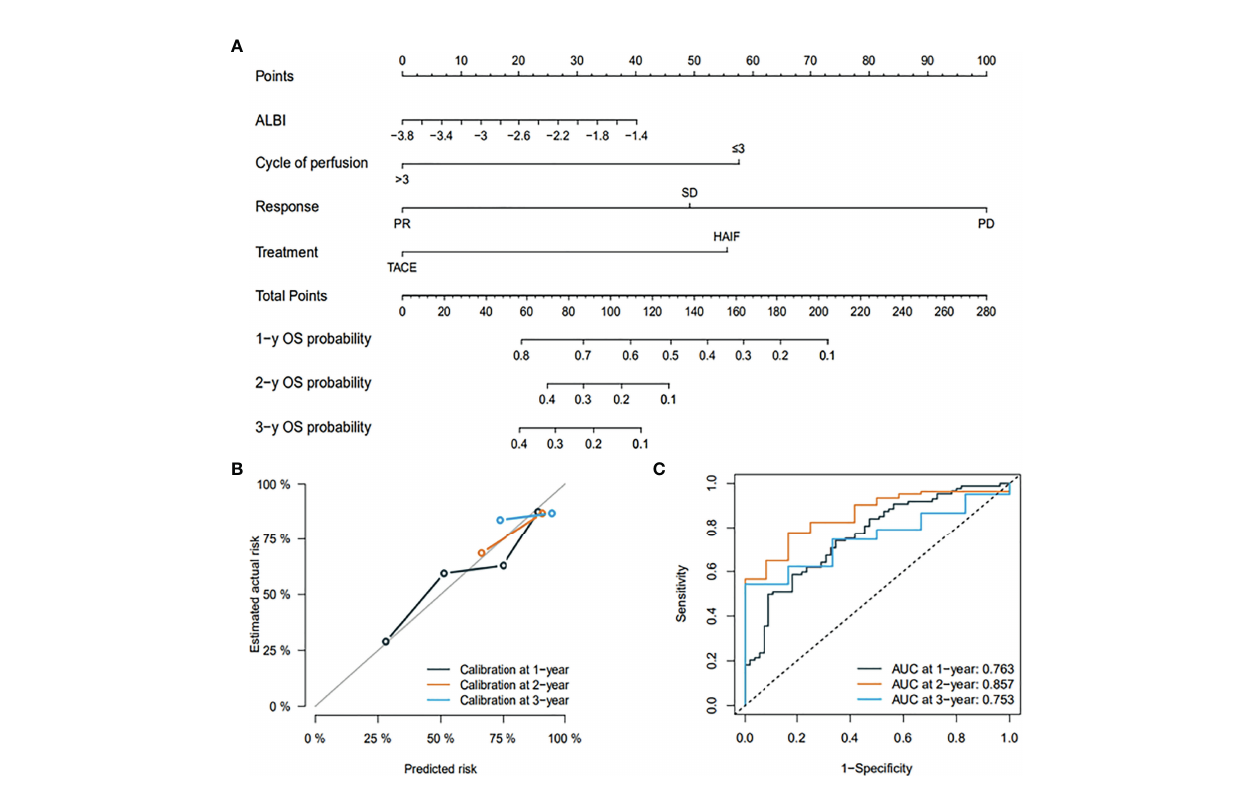
FIGURE 4 | (A) graph showing the prognostic model for predicting 1-, 2-, and 3-year OS in all patients. (B) Calibration plots for the prognostic outcome. (C) ROC curve for internal validation.